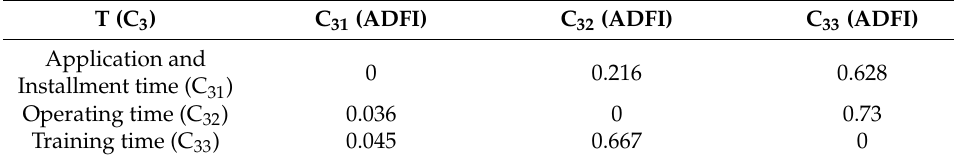
Table 8. Average direct fuzzy influence matrix T between Time (C 3 ) sub-criterions.